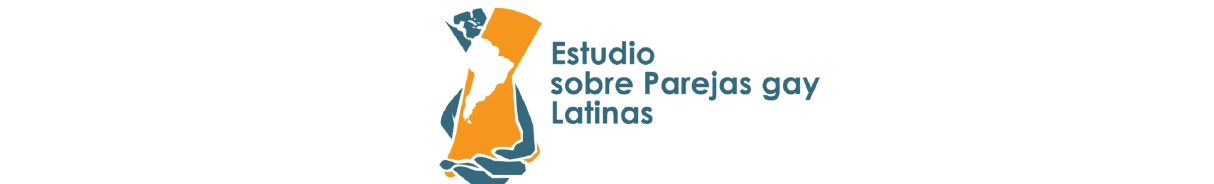
Figure 4. Latinos en Pareja